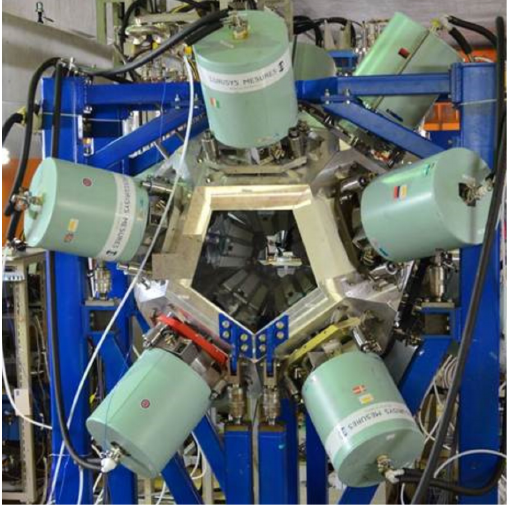
Figure 2. EURICA array consisting of 12 cluster detectors of EUROBALL at RIKEN RIBF in 2012 [49]. See text for details. Two-step fragmentation is used to study prompt radiation from Coulomb excitation or knockout reactions with the DALI2+ spectrometer. From several experimental cam- paigns, extensive and spectacular data was collected and, to large extent, published as discussed in Section 4.2. Very recently, in 2020–2021 the HICARI (High-resolution in- beam gamma-ray spectroscopy at RIBF) project [57] used a Ge-detector array to perform several experiments addressing this region. Efforts continue at NSCL (National Superconducting Cyclotron Laboratory, Michi- gan, USA) to contribute to the region [58], e.g., with spectroscopy using knock-out reac- tions [59], or the recent mass measurement of 80 Zr [60]. At GSI, revisited isomeric decay in 102 Sn and resulting effective neutron and proton charges based on state-of-the-art shell- model calculations were published [61], 13 years after the RISING [62] experiment.